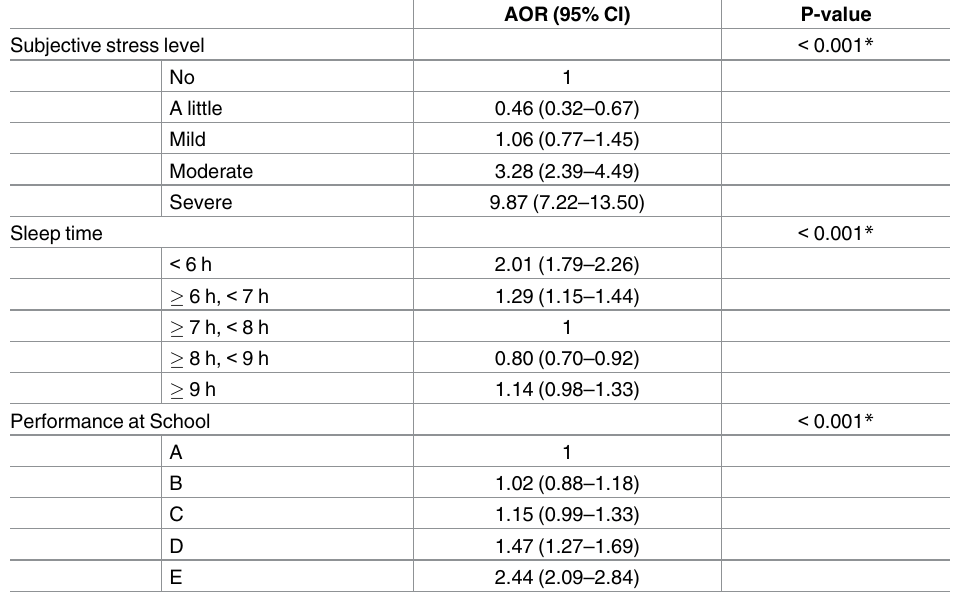
Table 3. Multiple logistic regression analyseswith complex sampling of subjective stress level, sleep time, and self-assessment of school performance (independent variables) for suicide trial (dependent variable).